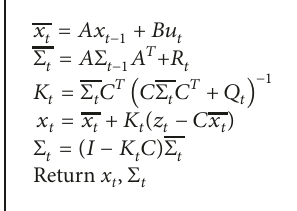
Algorithm 2: SLAM (𝑥 𝑡−1 , 𝑢 𝑡 ,𝑧 𝑡 , Σ 𝑡 ) .